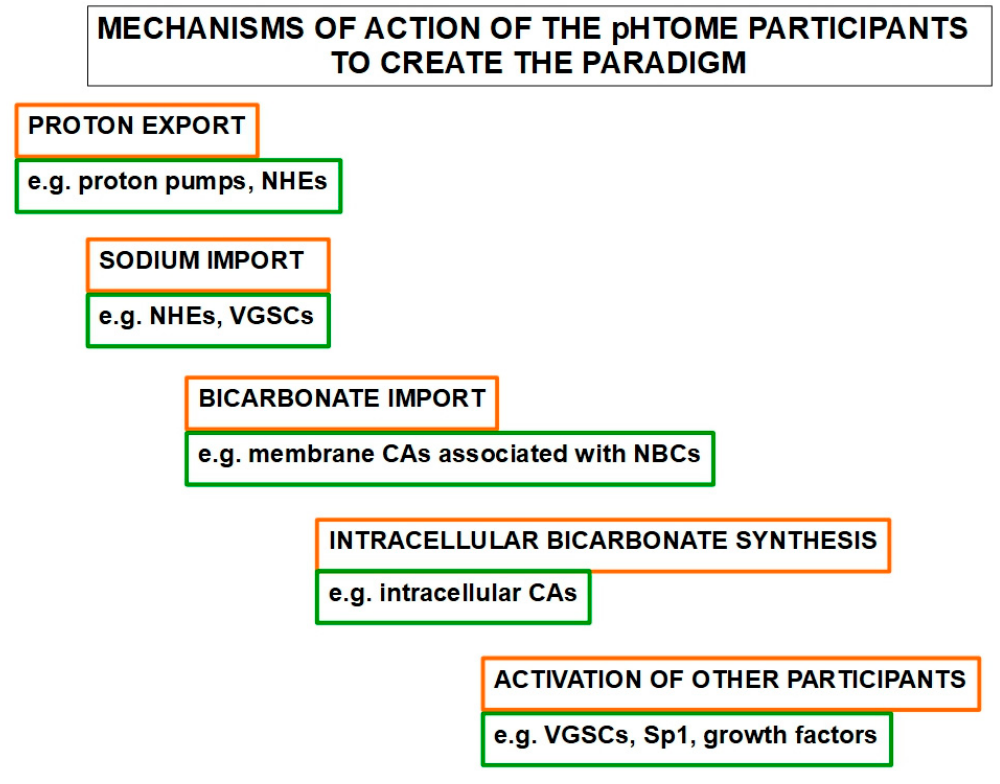
Figure 1. Mechanisms of action of the pHtome participants.